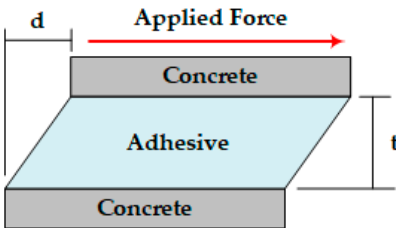
Figure 4. Shear strain mechanism. Where, d = horizontal deformation (shear displacement), t = vertical distance (adhesive layer thickness).